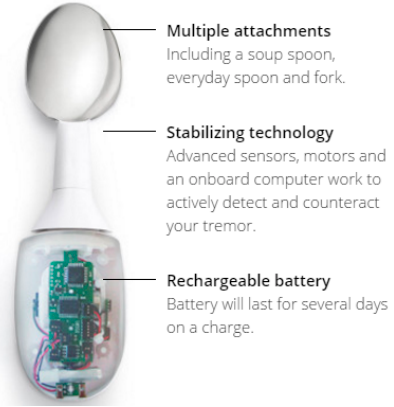
Figure 5. Stabilizing Spoon (https://www.liftware.com/).